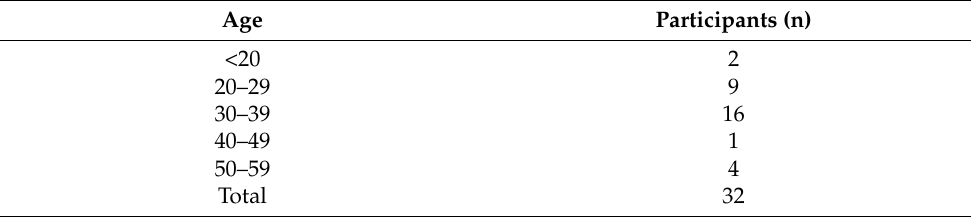
Table 1. Participants ages in a 10-year